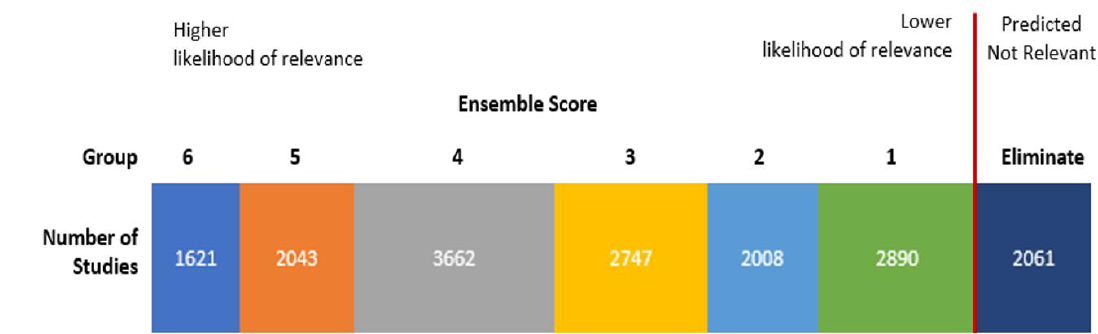
Figure 1. Results of ensemble supervised clustering using 32 seed studies. Studies with an ensemble score of 1 or more were screened manually for relevance.